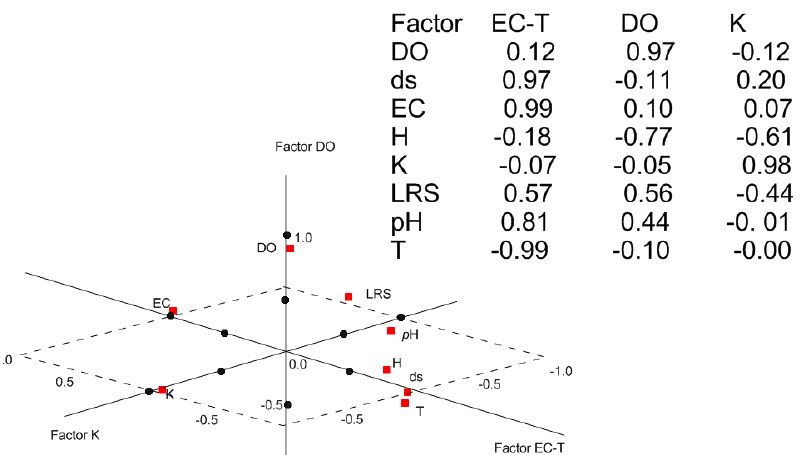
Figure 3. Three-dimensional visualization of abiotic habitat factors of electrical conductance (EC) (and distance from the seacoast, ds) and temperature (T) (EC–T), dissolved oxygen (DO), hydraulic conductivity (K) (and pressure head, H), and rotated correlation matrix showing correlations between LRS and EC–T, DO, and K factors.